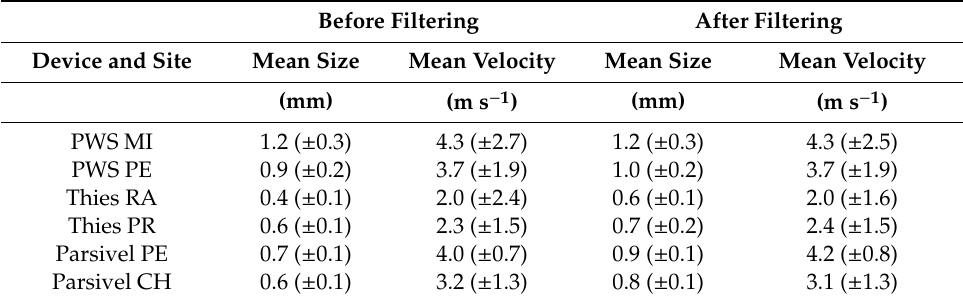
Table 3. Mean drop size and velocity ( ± standard deviation) before and after filtering. Before Filtering After